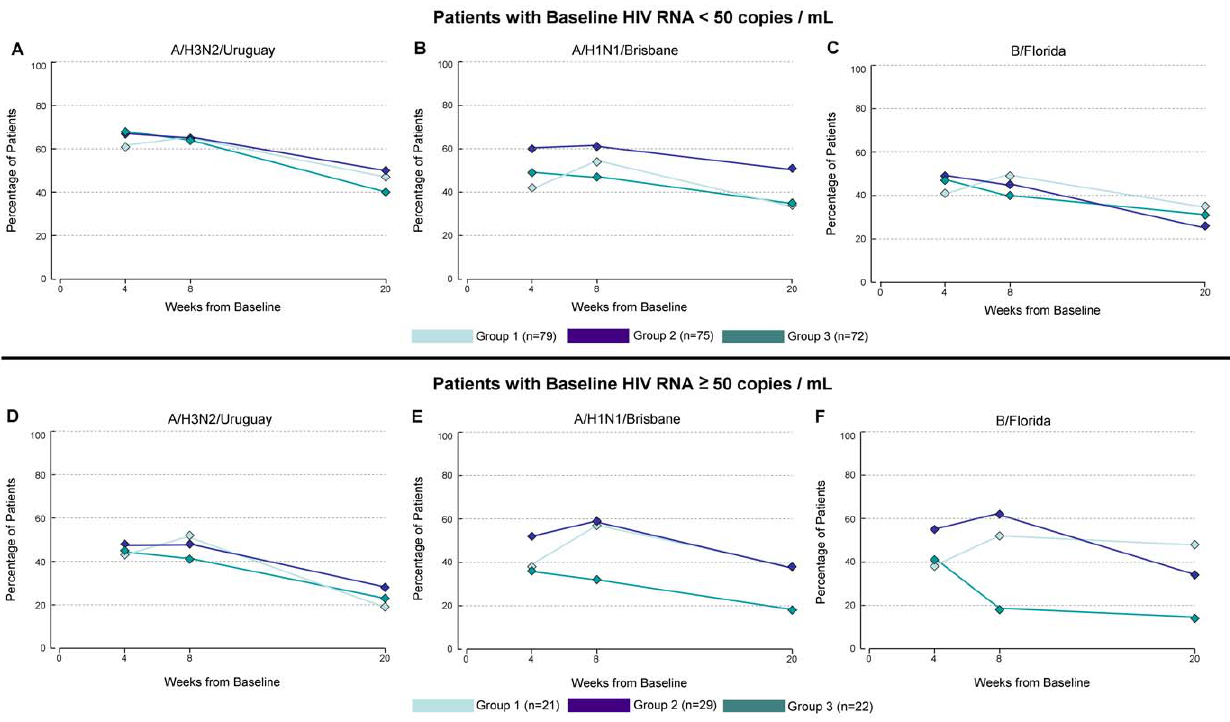
Figure 4. HAI titre doubling over time as a function of baseline HIV RNA suppression. The proportion of vaccine recipients achieving HAI doubling at week 4, 8 and 20 is described as a function of whether HIV RNA was below the lower limit of detection at baseline ( , 50 copies/mL) (n=226) or above this level (n=72). Each of the three antigens included in the administered vaccine (A/H3N2/Uruguay, A/H1N1/Brisbane, B/Florida) is considered. Group 1 (single dose followed by single dose booster at week 4), Group 2 (double dose followed by double dose booster at week 4) and Group 3 (single dose without booster at week 4) are depicted.